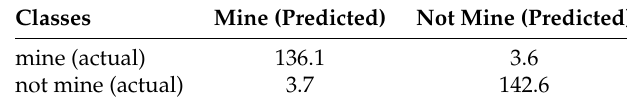
Table 5. Mean confusion matrix of the mine and dam localization model for 10-fold cross validation.